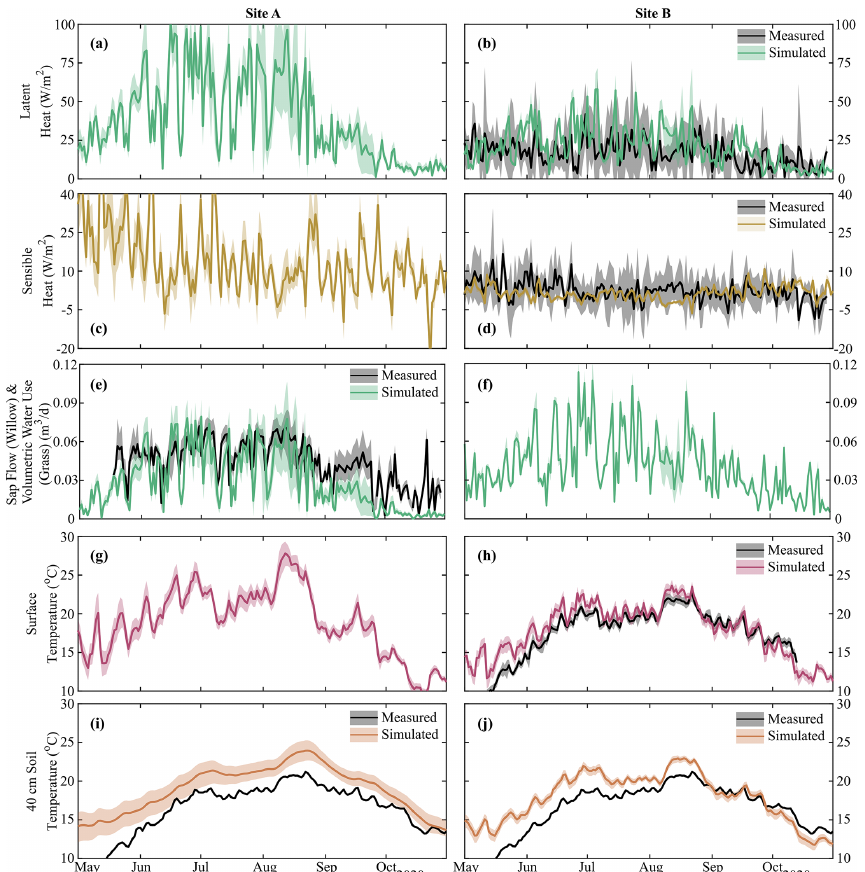
Figure 4. Simulation mean and upper and lower bounds of energy balance components of (a, b) latent and (c, d) sensible heat, (e, f) volumetric vegetation water use, and (g, h) surface and (i, j) soil temperature (40, 10, and 100cm in Fig. S4). Black lines show the mean of measured data with grey-shaded areas showing uncertainty and sub-hourly variability. Volumetric vegetation water at Site A shows sap flow within the willow, and that at Site B shows total volumetric water use of the grass. Note that soil temperature was not calibrated, and transpiration rates are shown in Fig. S4; sap flow for Willow 1 is identical to Willow 2 (Fig. 4e).